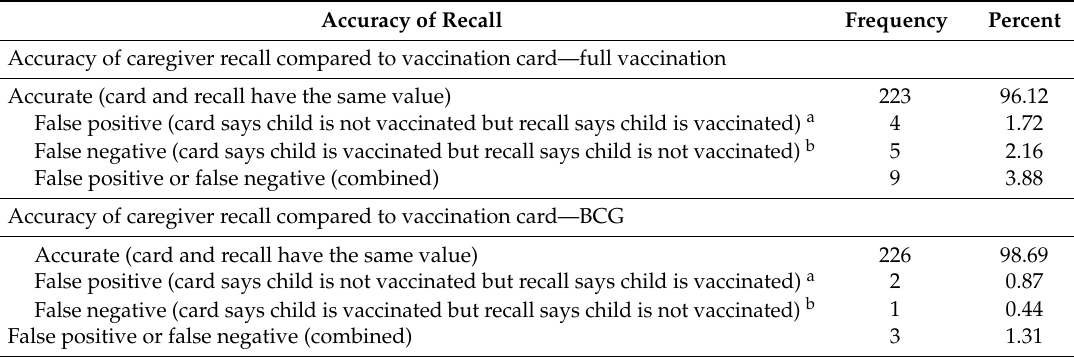
Table 6. Accuracy, recall false positives, and recall false negatives by